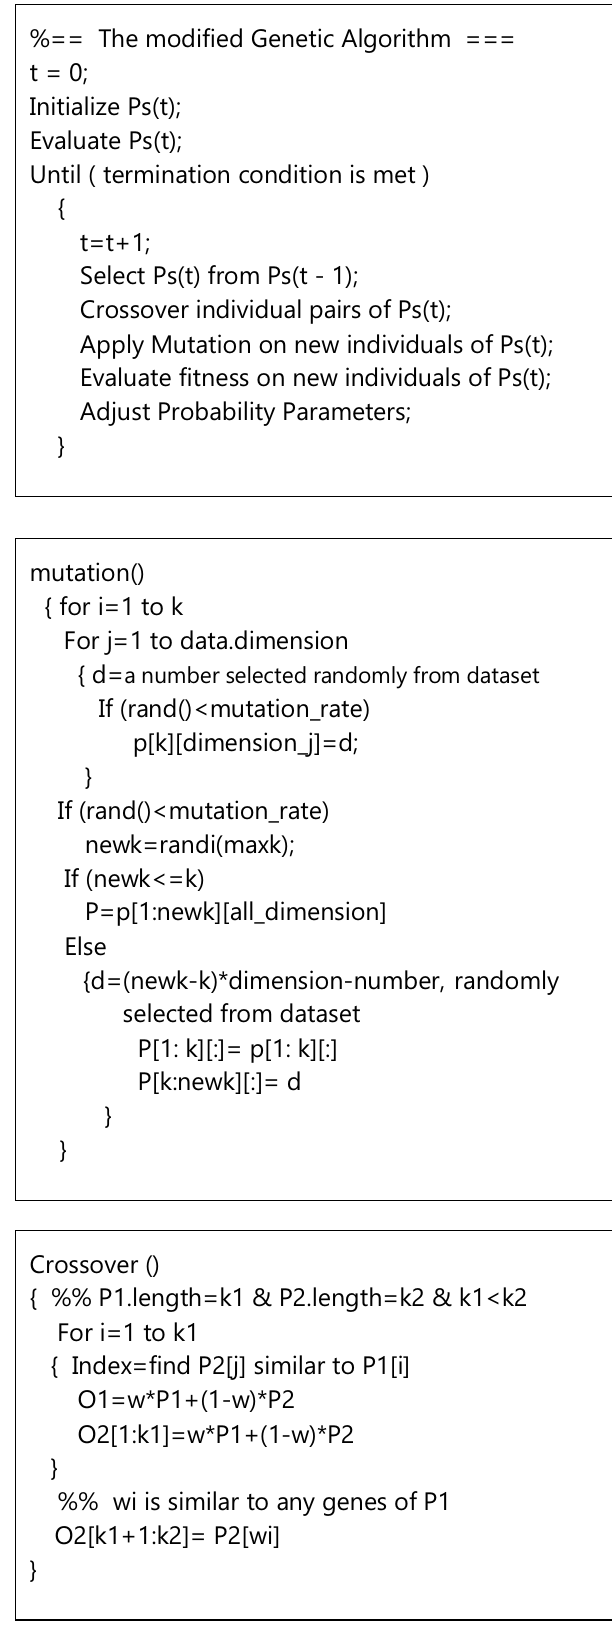
Fig. 3. Pseudo-code of modified genetic algorithm along with its crossover and mutation